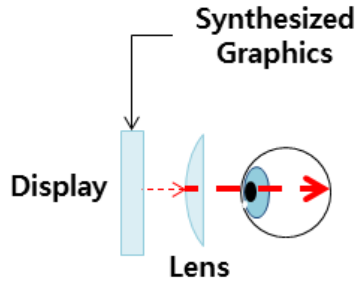
Figure 4. Schematic diagram of a non-see-through display